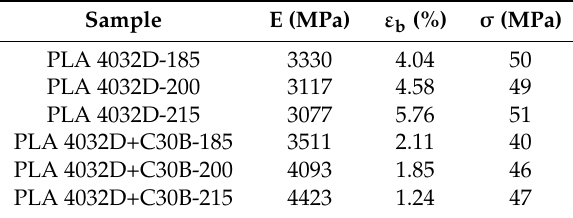
Table 5. Elastic modulus (E), elongation at break ( ε b ), and tensile strength ( σ ) of PLA 4032D and PLA 4032D+C30B specimens printed at different temperatures (standard deviation ± 5–10%).